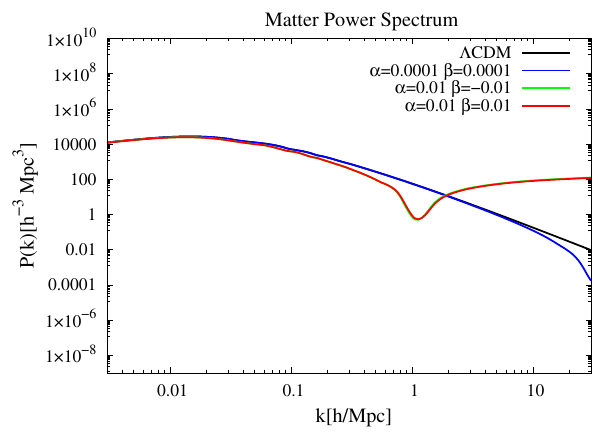
Fig. 3 Matter power spectra for the (cid:2) CDM and RVM, where the leg- end is the same as Fig. 1